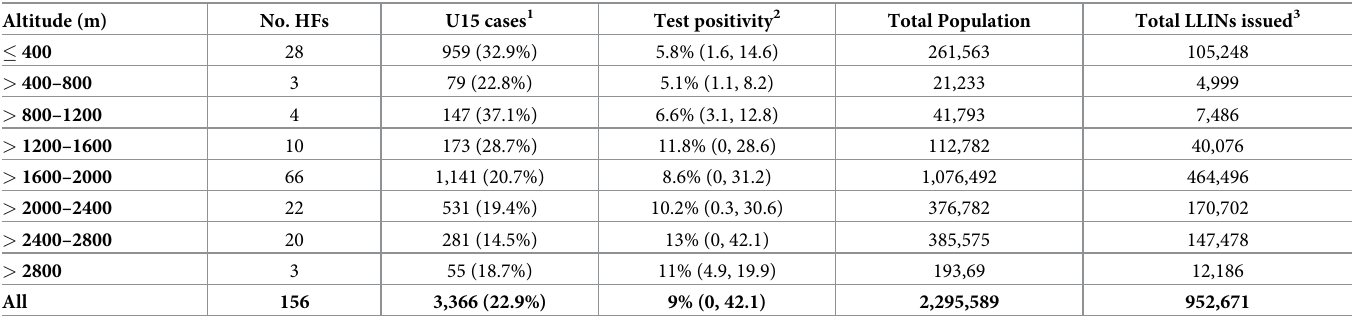
Table 3. Health facilities with few reported malaria cases in children < 15 years (on average, less than one case per monthly report) by altitude, PNG (2011–2019). Altitude (m) No. HFs U15 cases